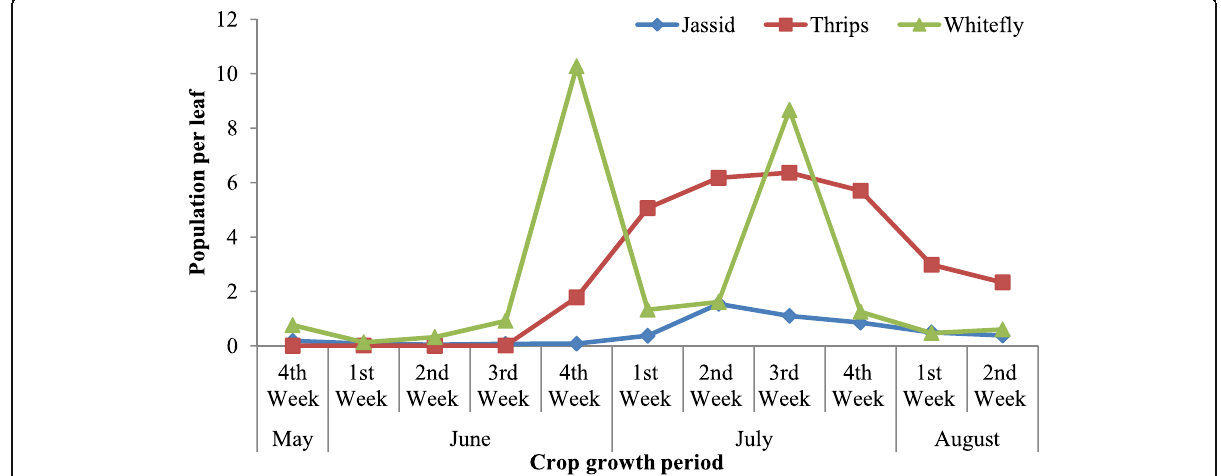
Fig. 1 Fluctuation in sucking insect pest complex population (data from the average of 12 cotton genotypes) during the growing